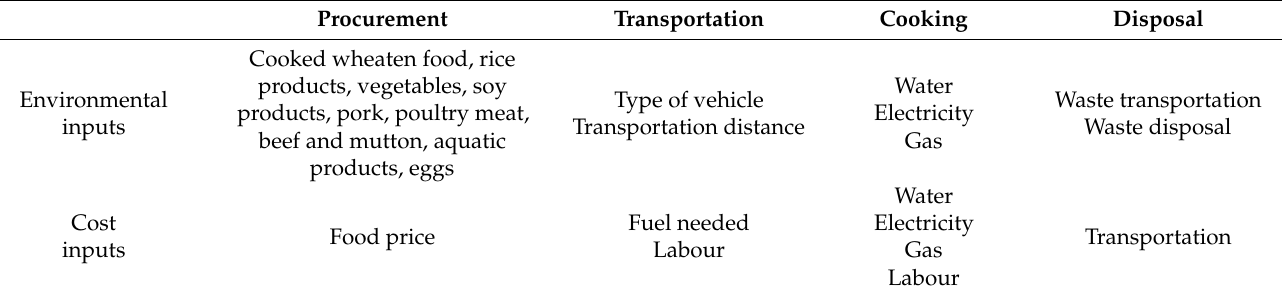
Table 2. LCA and E-LCC system boundaries and